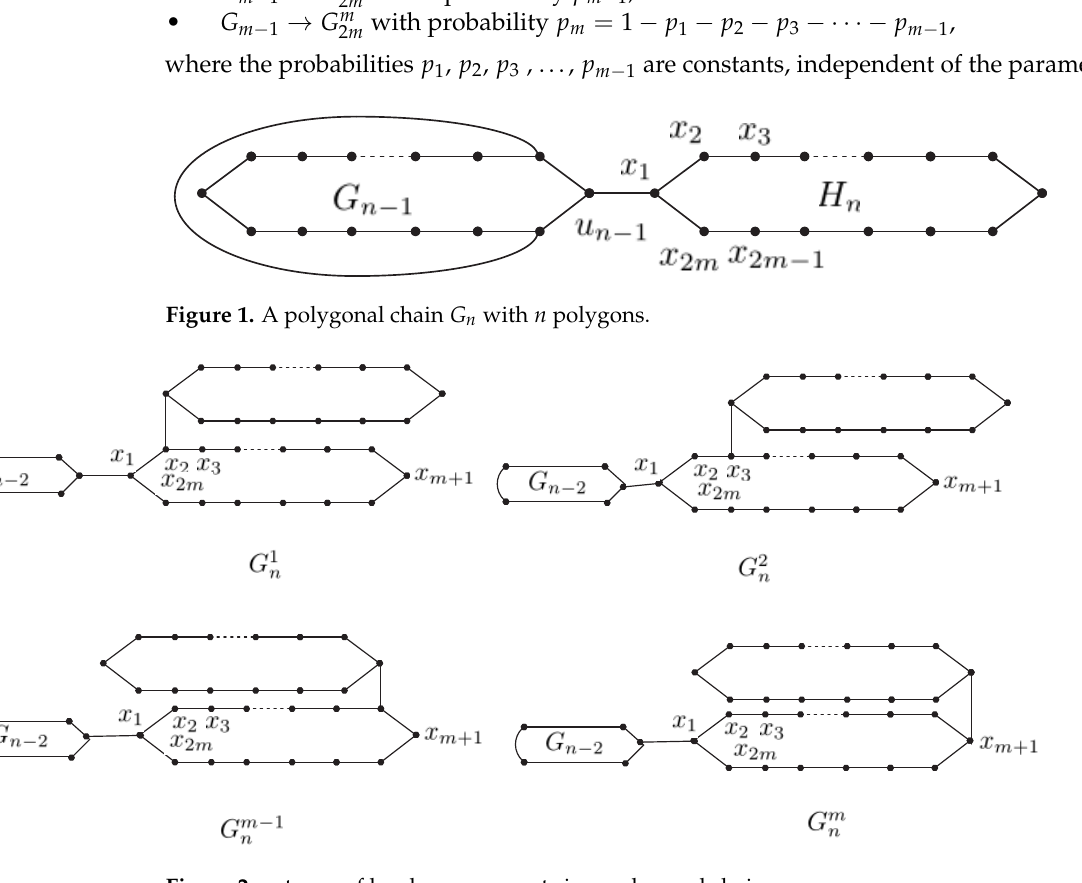
Figure 2. m types of local arrangements in a polygonal